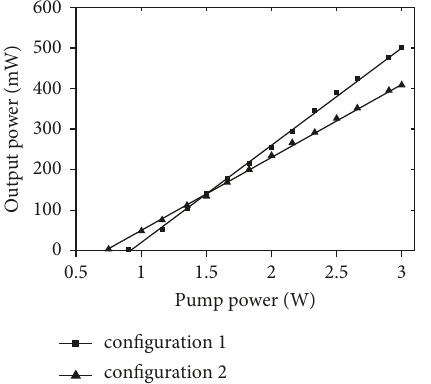
Figure 10: Tuning power versus